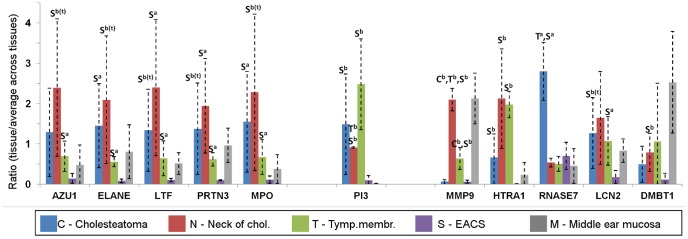
Overview of levels of 11 related proteins involved in inflammation, response to bacteria, and/or protein degradation.Letters above the standard deviation bars indicate the tissues compared to which differences were found in the pairwise comparisons between the four keratinizing tissues. Left: Leukocyte-associated proteins. Middle: Inhibitor of enzyme activity. Right other protein degrading and/or immune-response related proteins. a: Group A proteins, b: Group B proteins, b(t): Triplicate values in group B. Gene names below the columns. Tymp Membr: Tympanic membrane; Chol: Cholesteatoma.